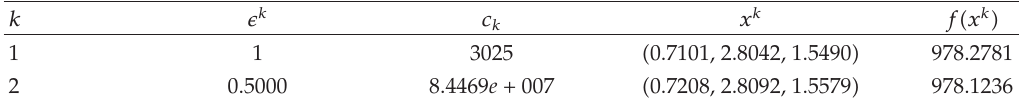
Table 4: Result of Example